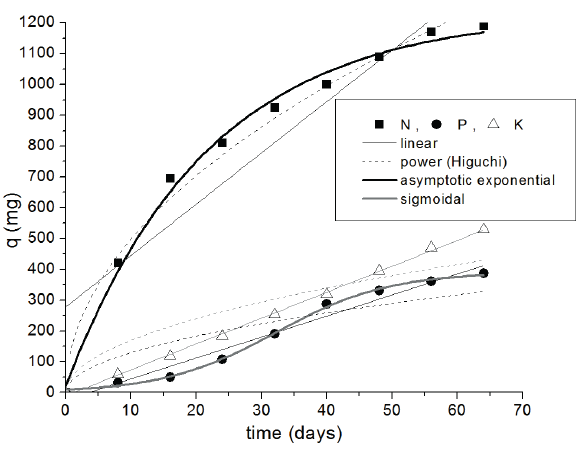
Figure 11: Release kinetics of N, P, and K fitted to different